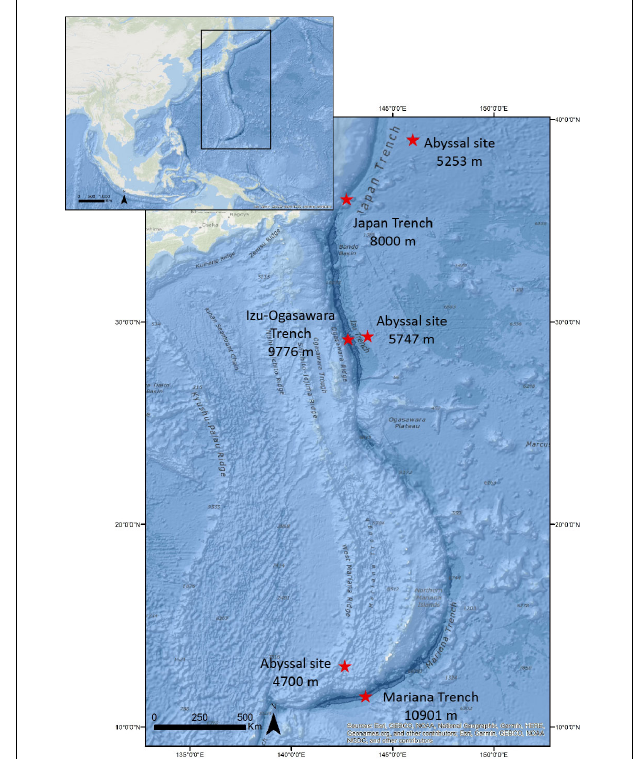
FIGURE 1 | Sampling sites and related